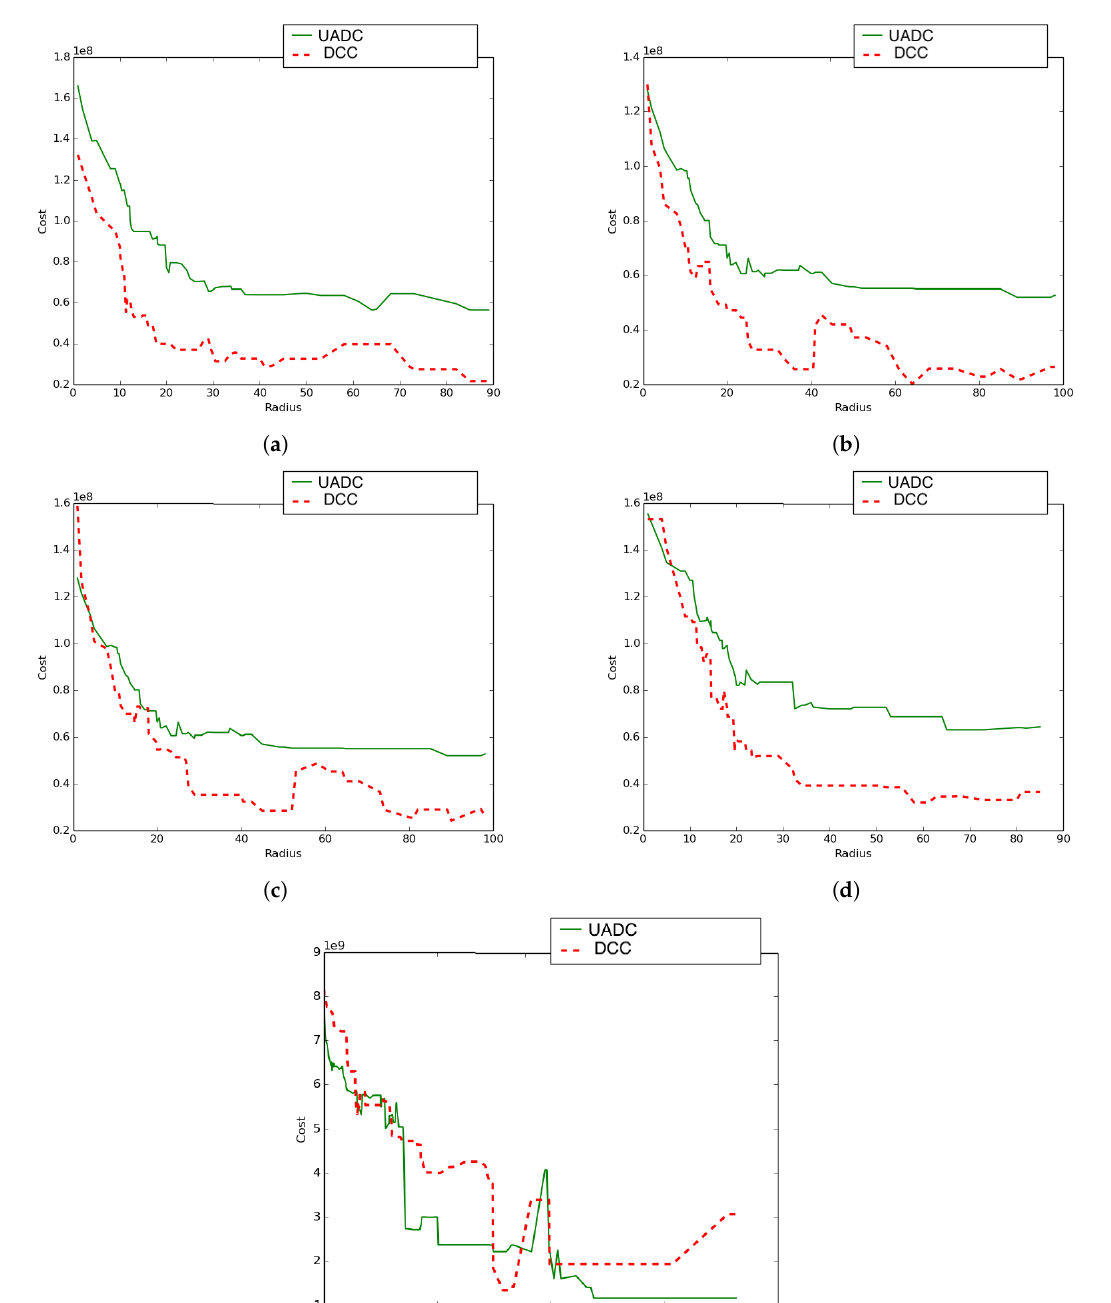
Figure 14. Algorithms comparison on different topologies. ( a ) Case 1; ( b ) Case 2; ( c ) Case 3; ( d ) Case 4; ( e ) Case 5. UADC, UAV-Aware